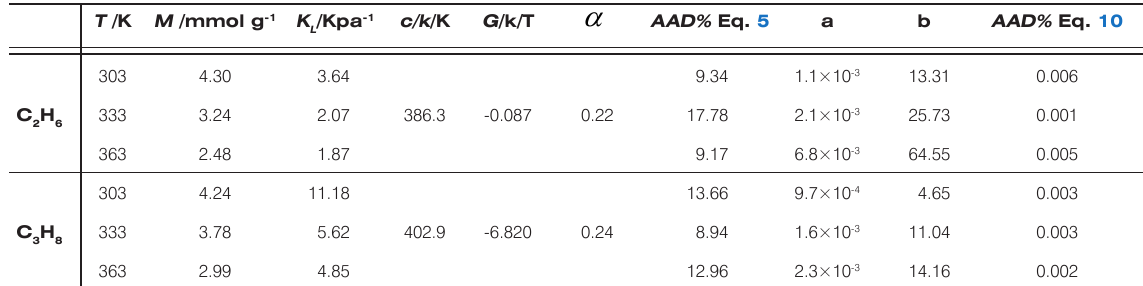
Table 1. Values of the parameters obtained by applying Eqs. 5 and 10 to the experimental equilibrium isotherms of C the Norit activated carbon [14]. T /K M /mmol g -1 K